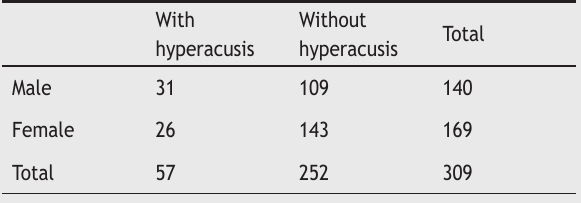
Table 1 Gender distribution between the study groups.